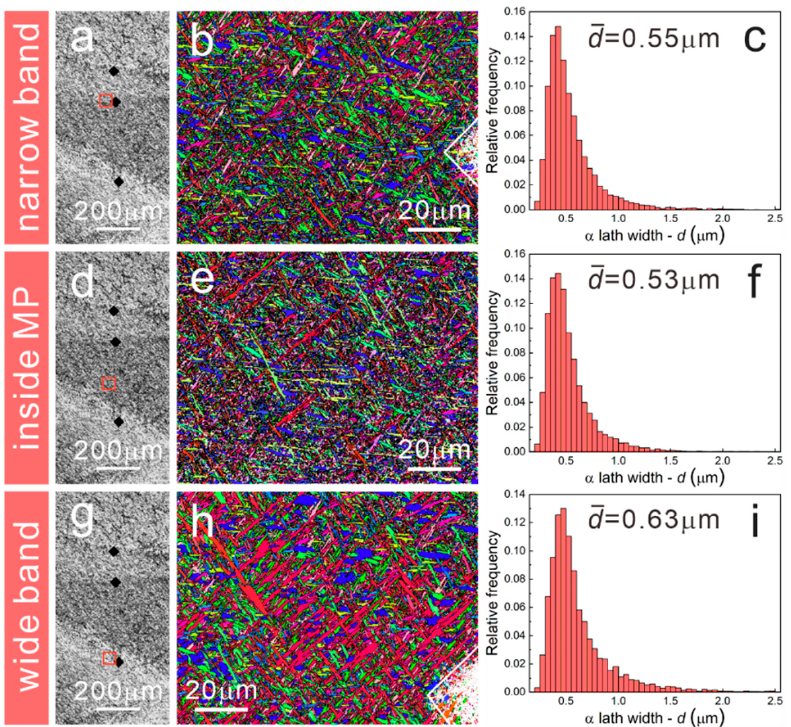
Figure 7. OM images and corresponding inverse pole figures (IPFs), α lath width distribution of the EPT7 sample: ( a – c ) narrow band, ( d – f ) inside the MP, ( g – i ) wide band. (The black diamonds are the marking indentations of wide band and narrow band, and the red square is the EBSD scanning region.)